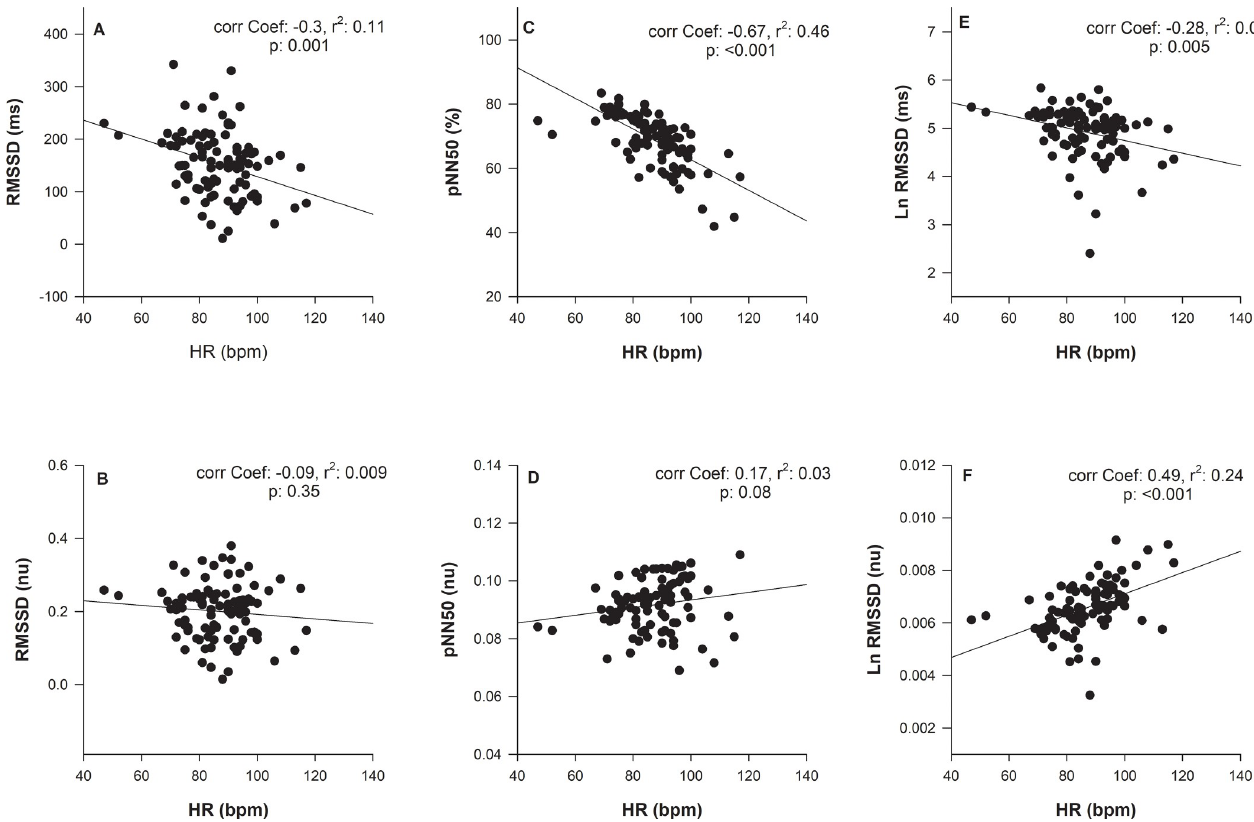
Fig 7. The relationship between mean HR (HR mean ) and heart rate variability (HRV). RMSSD: the square root of the mean of the squared differences between adjacent normal RR intervals (A); pNN50: percentage of differences between adjacent normal RR intervals that are > 50 ms (C); LnRMSSD: natural logarithm of the square root of the mean sum of the squared differences between R–R intervals (E).